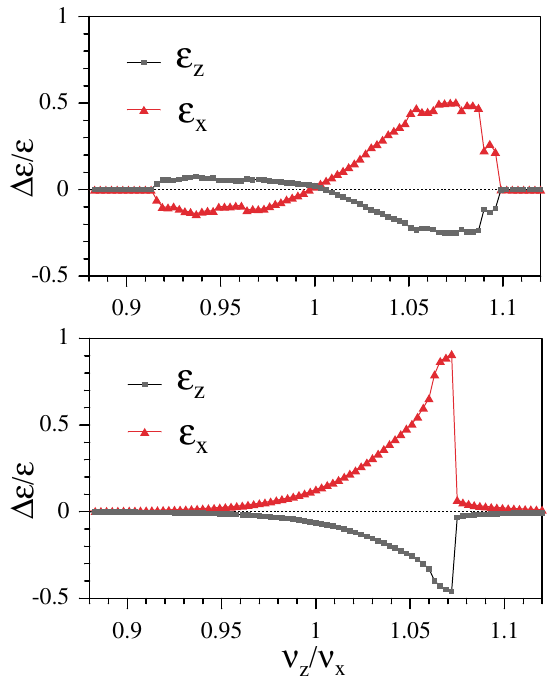
FIG. 8. (Color) Simulation results showing final relative emit- tance change for initial KV (top panel) and WB (bottom panel) distributions ( (cid:10)